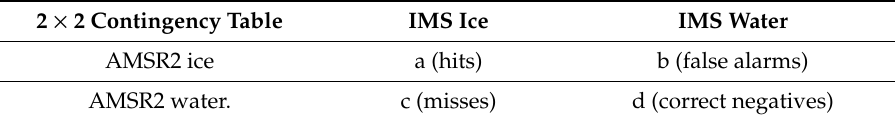
Table 1. A 2 × 2 contingency table.